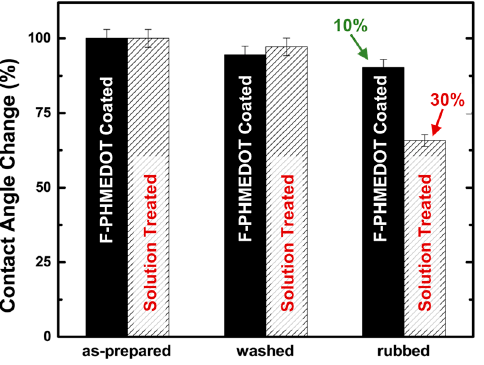
Figure 3. Change in apparent water contact angles of a vapor-coated (F-PHMEDOT) and solution- Change in apparent water contact angles of a vapor-coated (F-PHMEDOT) and coated cotton fabric before and after solvent washing and mechanical rubbing. solution-coated cotton fabric before and after solvent washing and mechanical rubbing. Fibers 2018 , 6 , x FOR PEER REVIEW